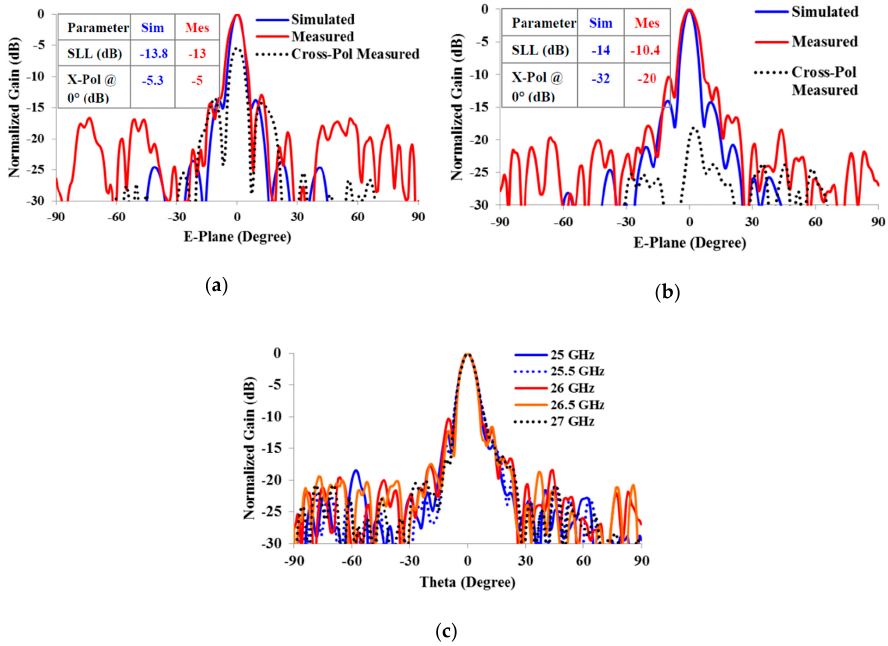
Figure 9. Vertically polarized radiation pattern results of asymmetric patch reflectarray with embedded ground slots for: ( a ) Non mirror elements at 26 GHz; ( b ) Mirror elements at 26 GHz; ( c ) Measured E-plane with mirror elements at different frequencies.